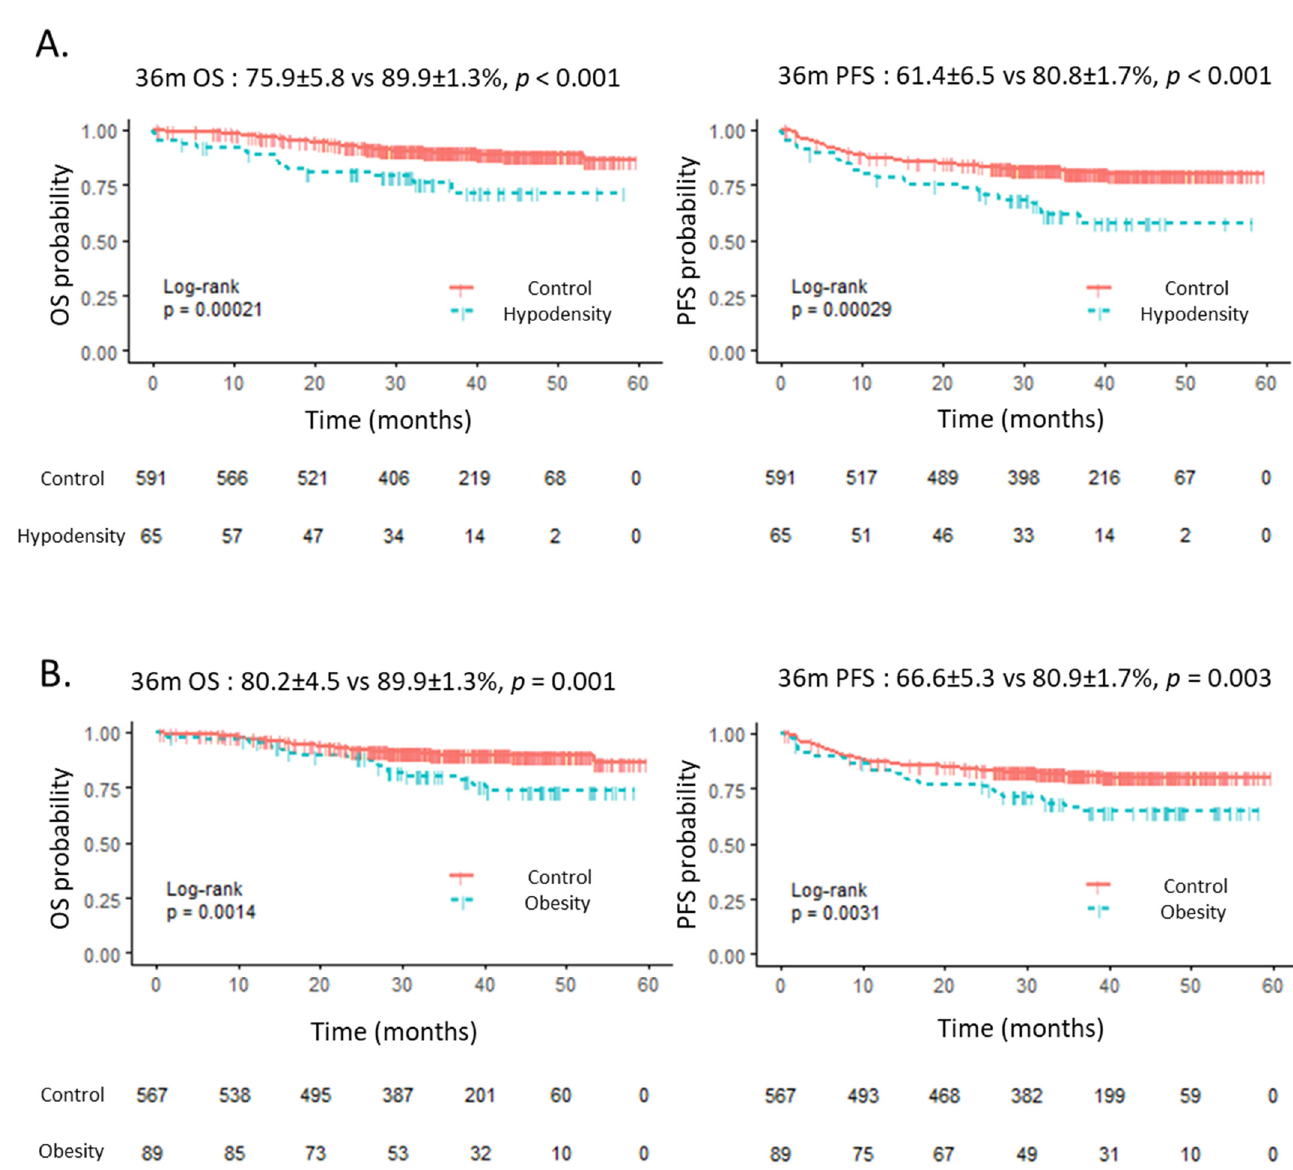
Figure 2. OS and PFS according to muscle hypodensity ( A ) and obesity ( B ). OS: overall survival. PFS: progression-free survival.